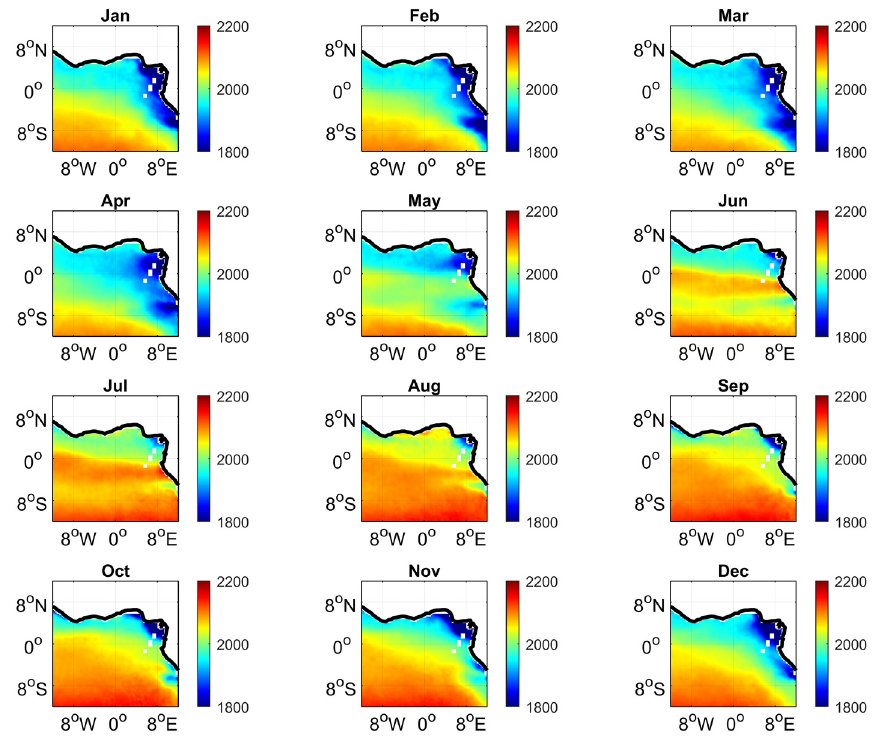
Figure 4. Climatology of DIC (in µmol kg − 1 ) obtained from Equation (3) with the monthly fields of MODIS SST and SMOS SSS. The DIC climatology is calculated over the January 2010 to September 2019 period.